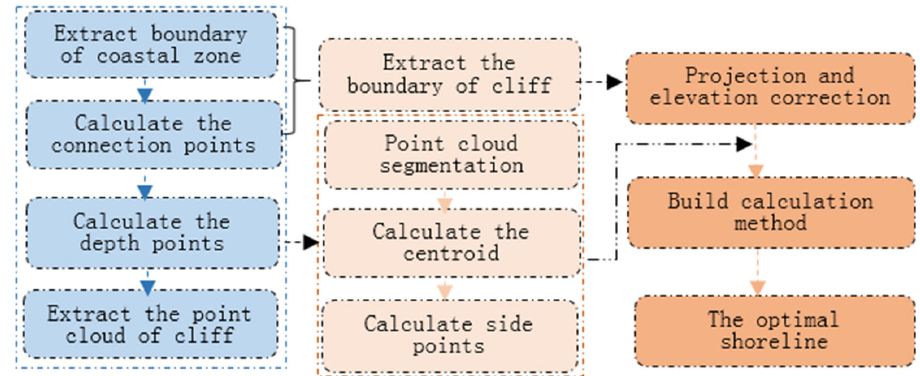
Figure 2. The methodological flow